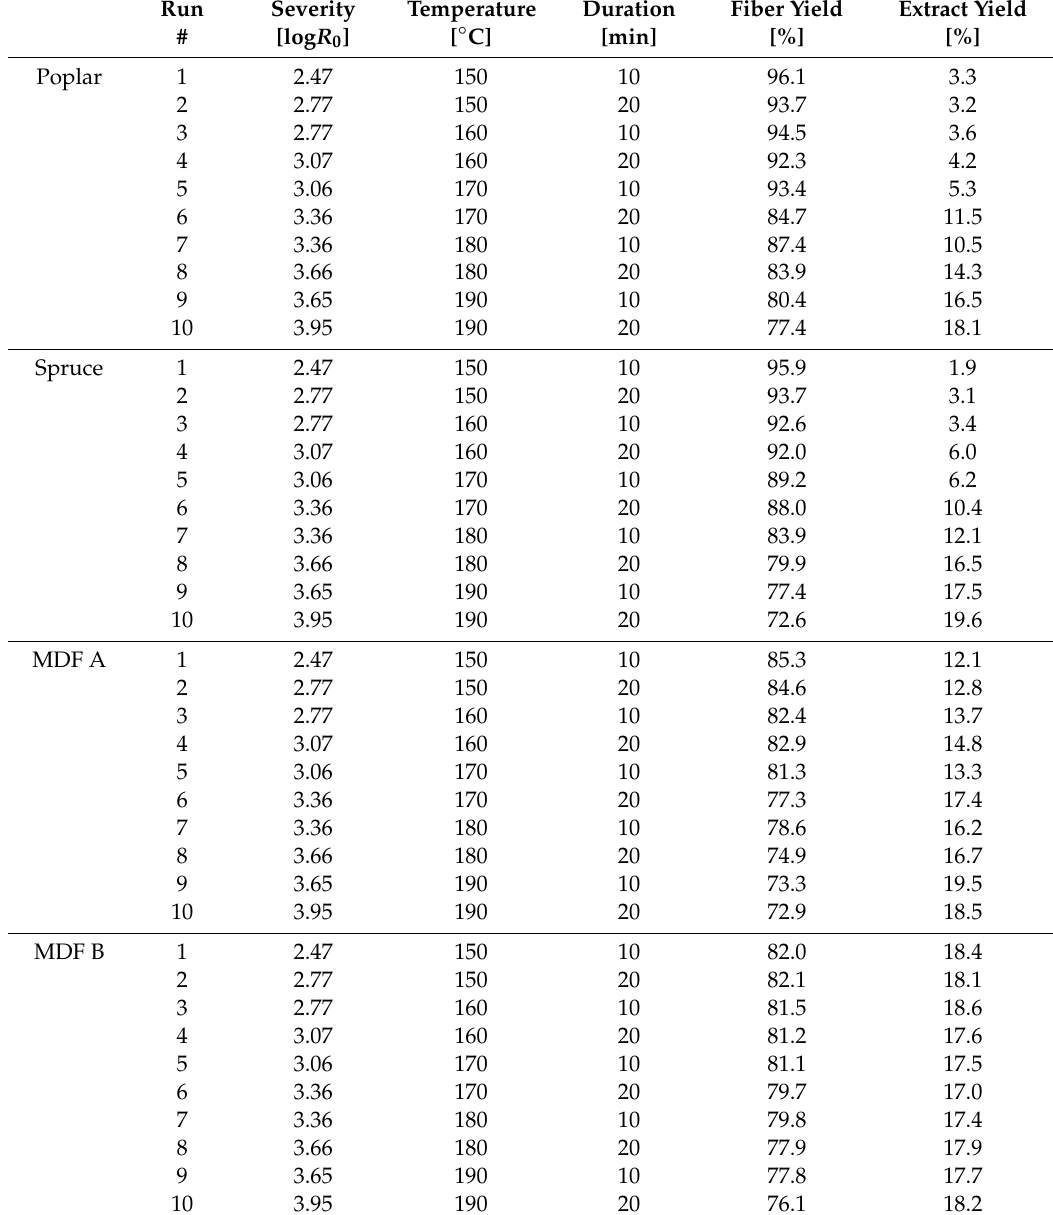
Table A1. Fiber and extract yield of poplar, spruce, and MDF sample A and B at treatment severities from 2.47 to